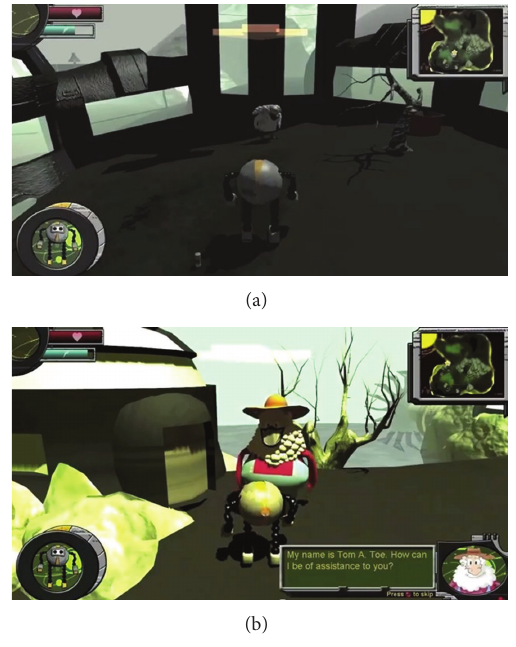
Figure 7: Nonplayable characters: (a) Dr. Jacob in level 1; (b) Tom A. Toe in level